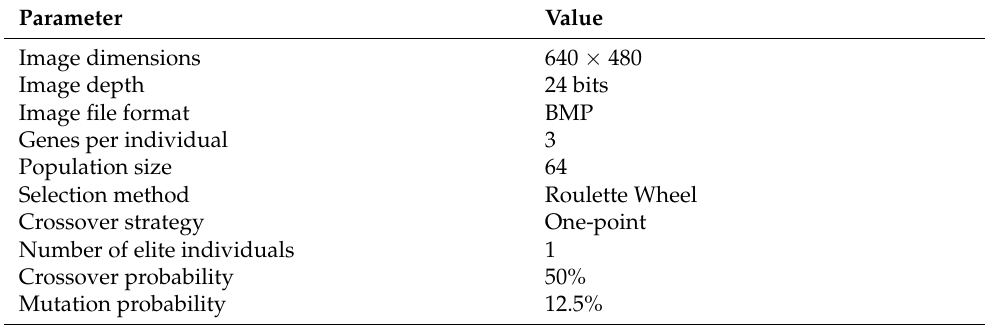
Table 1. CDS design